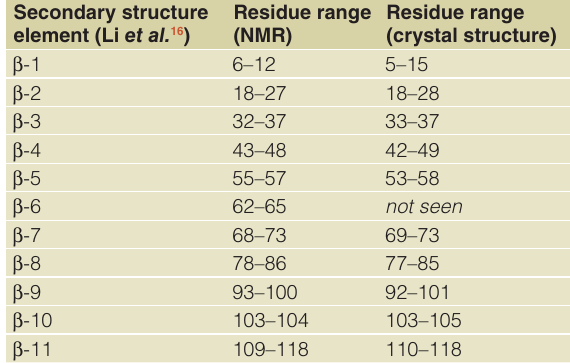
Supplementary table 2. Comparison of the secondary structural elements assigned by Li et al. 16 by NMR and those observed in the crystal structure (Figure